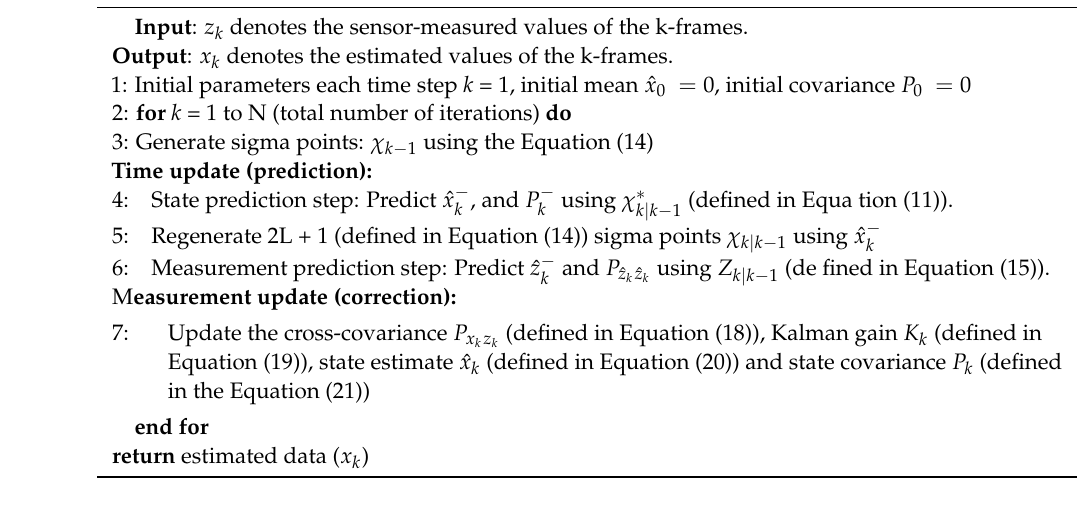
Algorithm 2: Unscented Kalman Filter (UKF) [26]